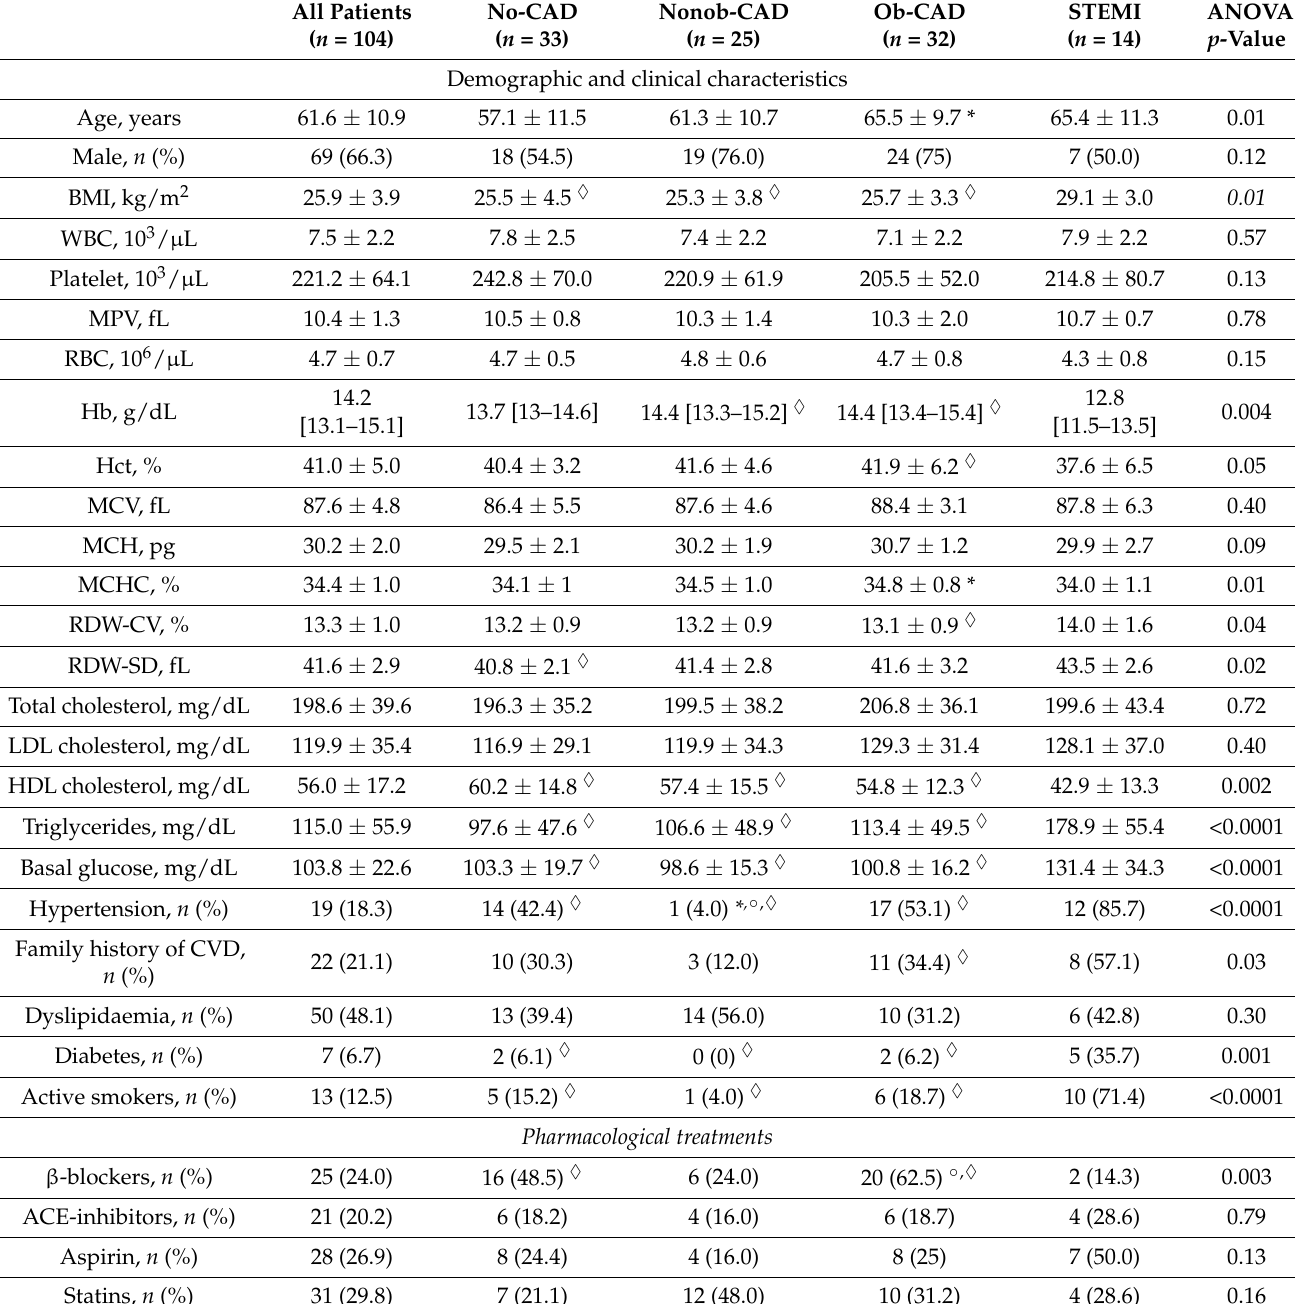
Table 1. Demographic and clinical characteristics of the study